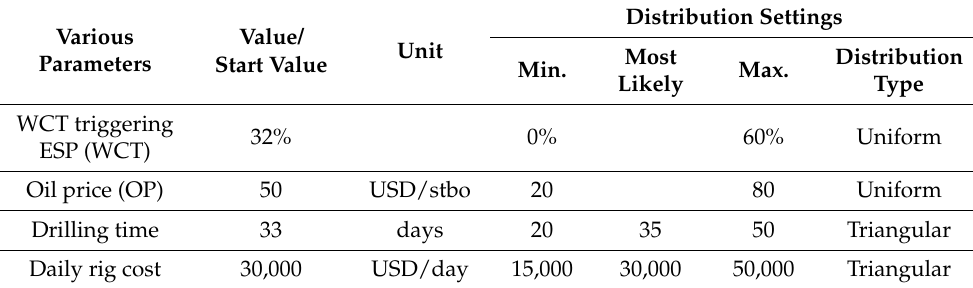
Table 4. The parameters with the greatest influence on profitability and their ranges.